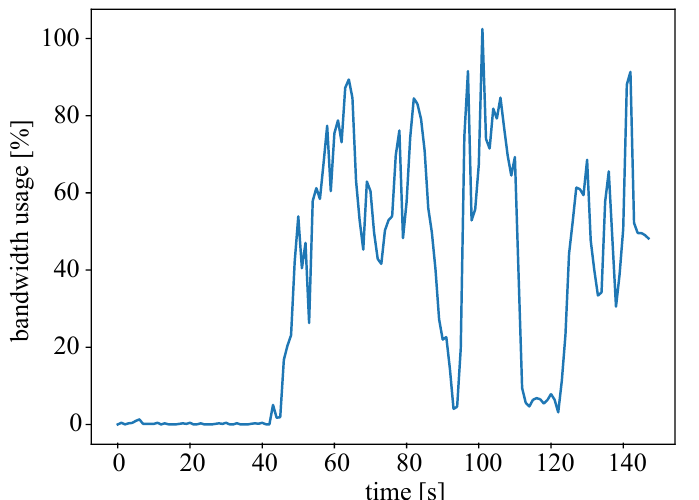
Figure 12. Exemplary bandwidth usage in the test environment with data streams of finite length allocated by MAS2.